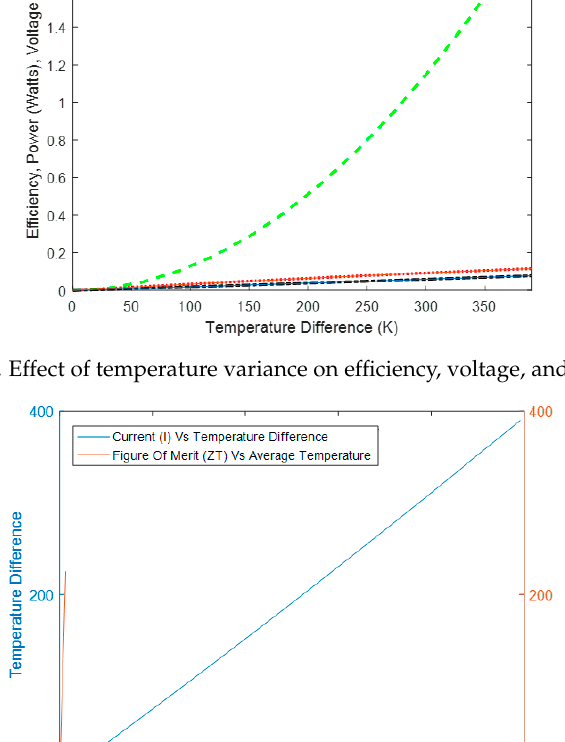
Figure 9. Effect of temperature variance on current and the thermoelectric figure of merit ( 𝑍𝑇(cid:3364) ).